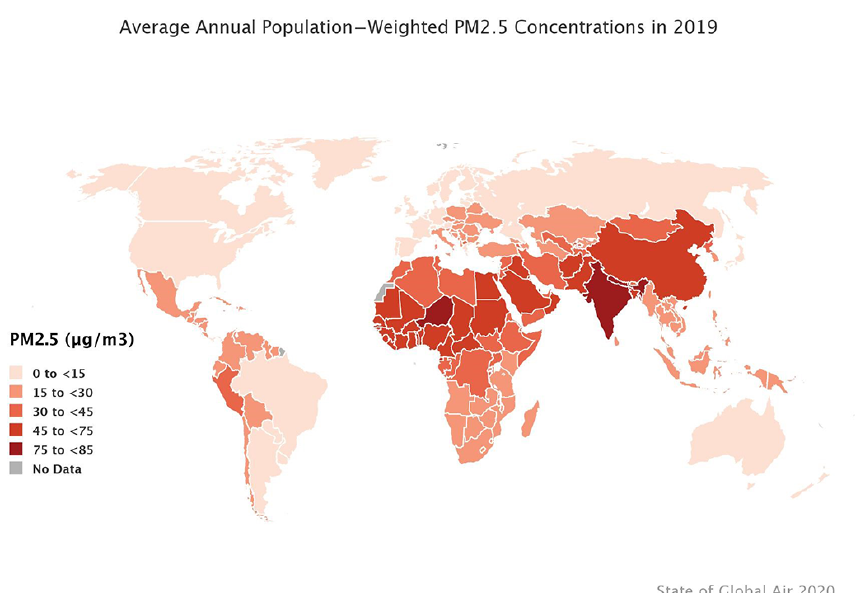
Figure 1. Global distribution of population-weighted annual PM 2 . 5 concentrations for 2019 (HEI, 2020). Figure produced from https: //www.stateofglobalair.org/data/#/air/map (last access: 10 December